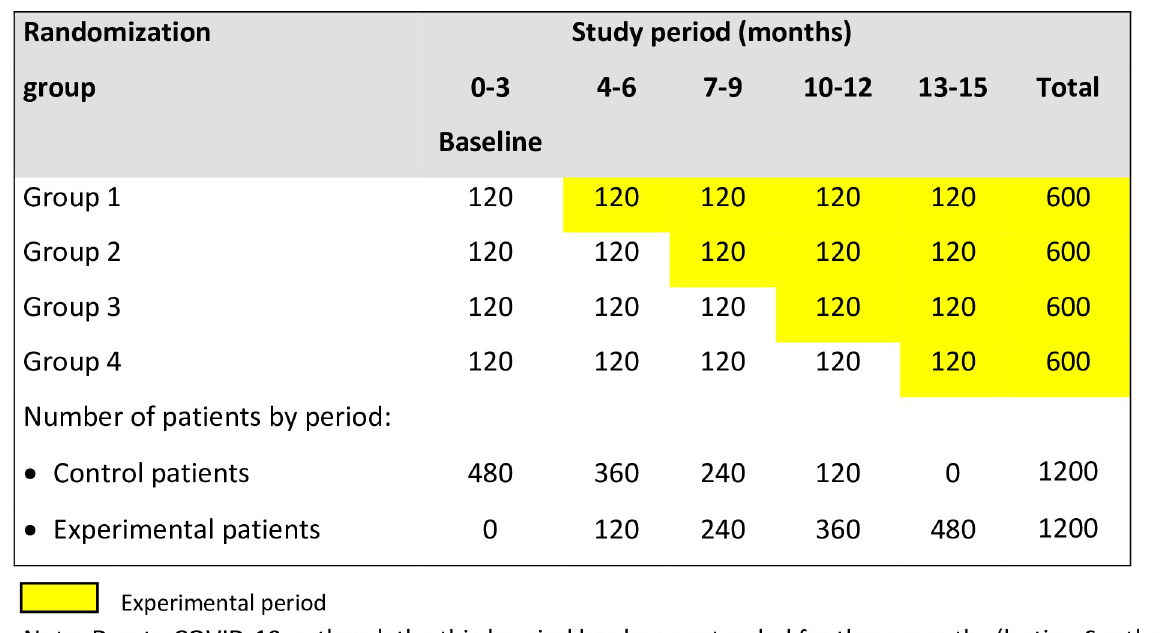
Fig 1. Diagram of the ERAS-Gyneco Piemonte study with the expected number of patients in each group of hospitals and study period.